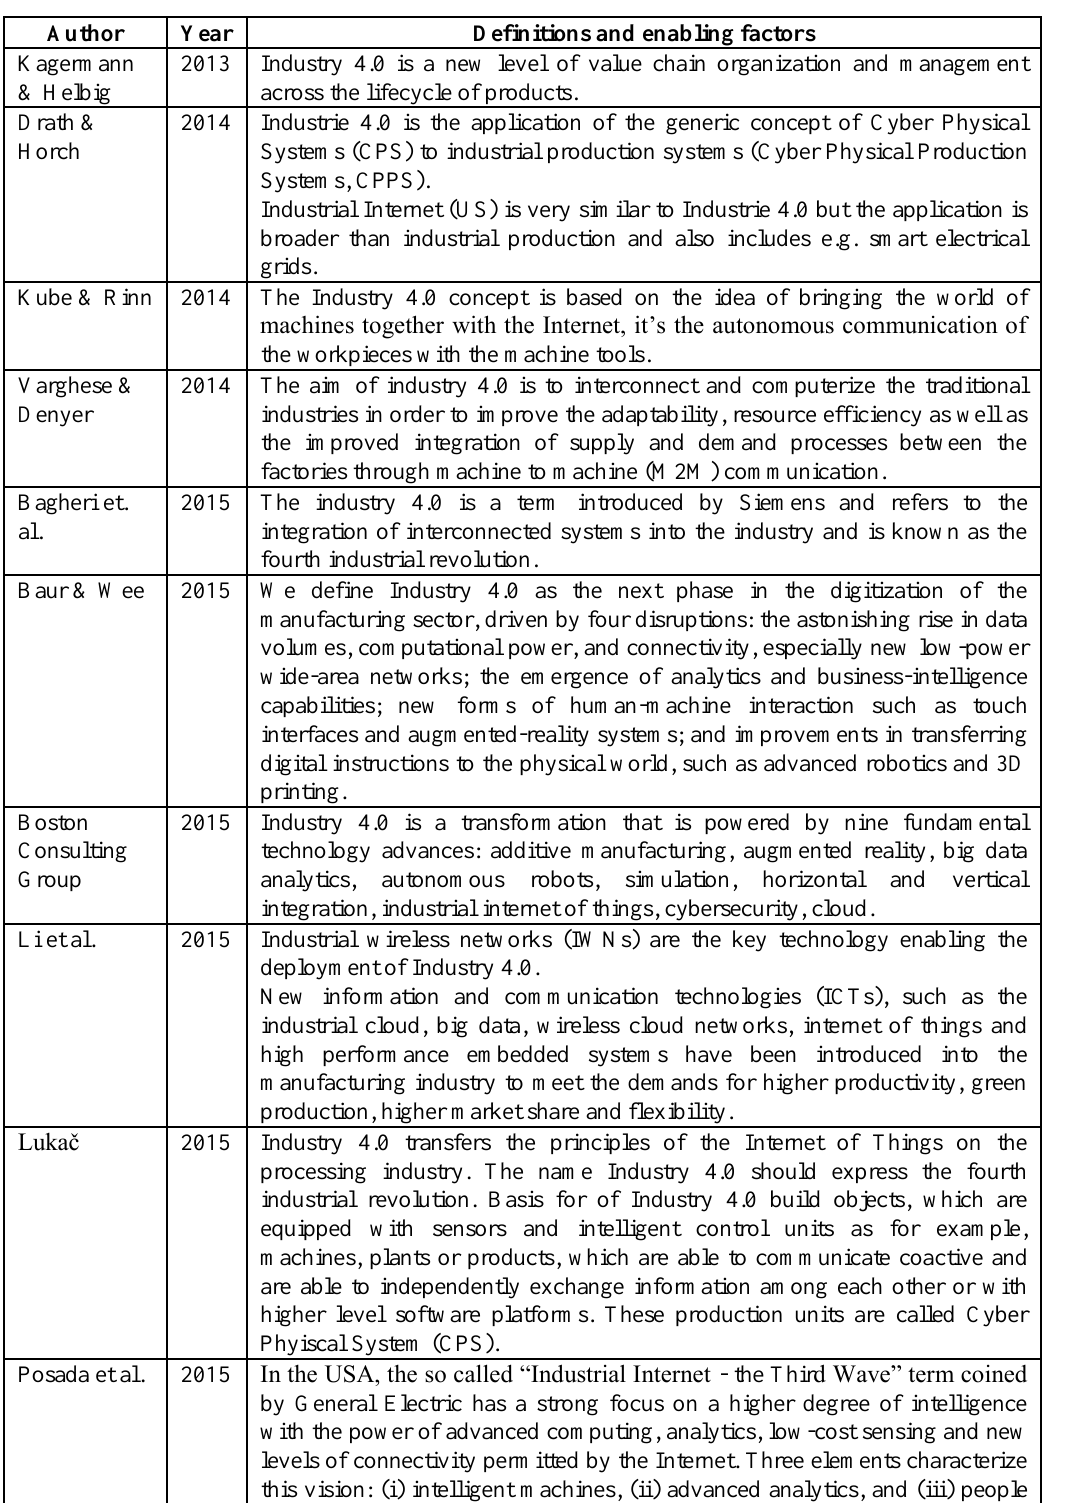
Table 1: Industry 4.0’s Main Definitions and Enabling